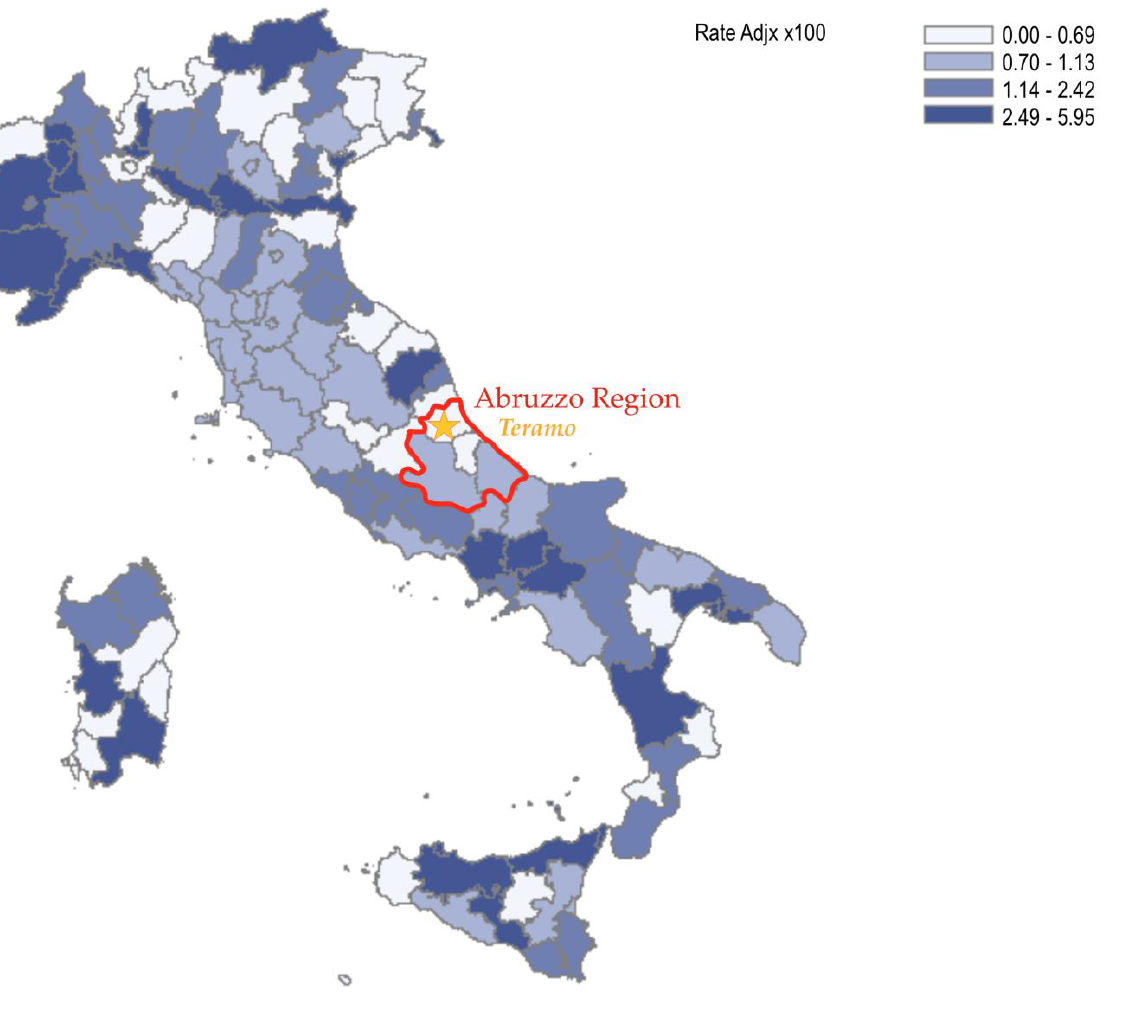
Figure 4. National and Regional death rate for non-ruptured AAA. The color gradient showed the incidence rate of AAA in each Italian incidence rate of AAA in each Italian province.